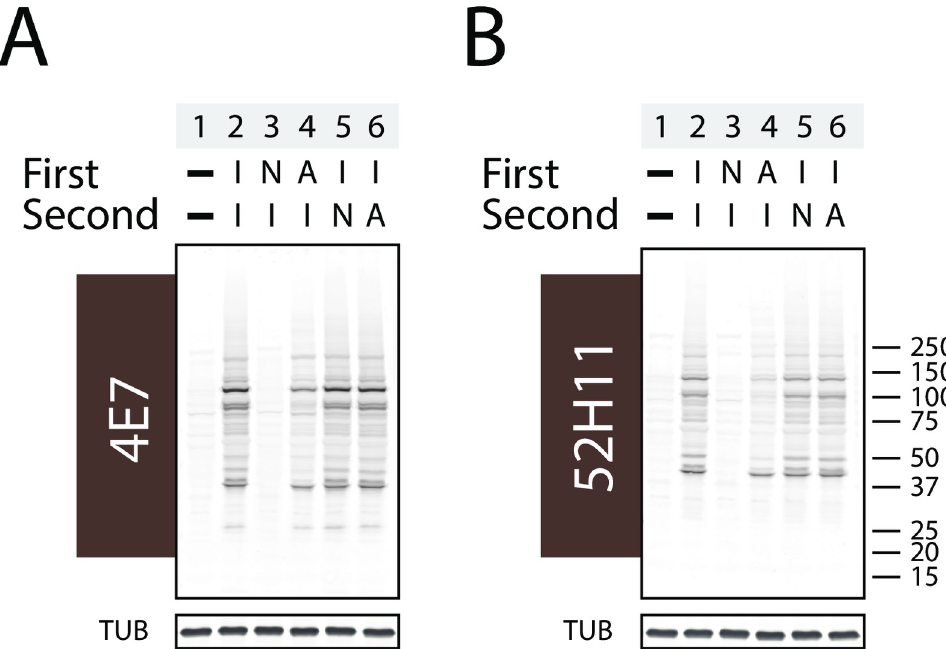
Fig 3. Effect of competitive blocking by cysteine alkylation on antibody binding to IAM-treated proteins. Potentially competitive cysteine alkylating agents were added either before or after IAM to determine whether cysteine modification could affect recognition of proteins incubated with IAM. Each sample of whole 293 cell lysate was sequentially exposed to different combinations of alkylators (labeled “First” then “Second”). The first lane of each panel was not treated with alkylators. The second lane was treated with IAM only. The third lane was treated first with NEM and then with IAM. The fourth lane was treated with acrylamide and then with IAM. The fifth lane was treated with IAM then NEM. And the sixth lane was treated with IAM followed by acrylamide. I = IAM (2mM); A = acrylamide (2mM); N = NEM (2mM). After Western blotting, membranes were probed with 4E7 (A) or 52H11 (B).